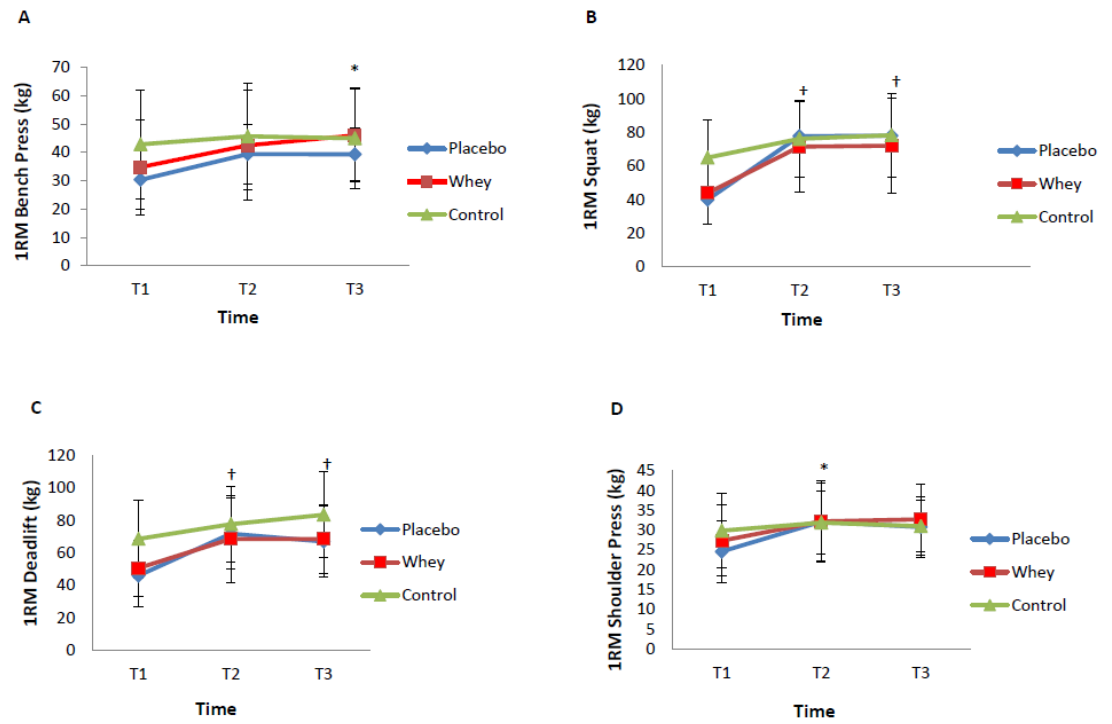
Figure 1. One-repetition maximum strength changes over time for the bench press ( A ), the squat ( B ), eth deadlift ( C ) and the shoulder press ( D ) from pre (T1); 12 wks post (T2); 24 wks post (T3) in the whey, placebo and control groups. Values are reported as means ± SD. Data were analysed using a two-way ANOVA with multiple comparisons (two groups x three time points) between the whey protein and placebo groups. The control group was examined using a one-way ANOVA with repeated measures. * p < 0.05, † p < 0.001, significant changes between T1, T2 and T3 between whey and placebo groups.